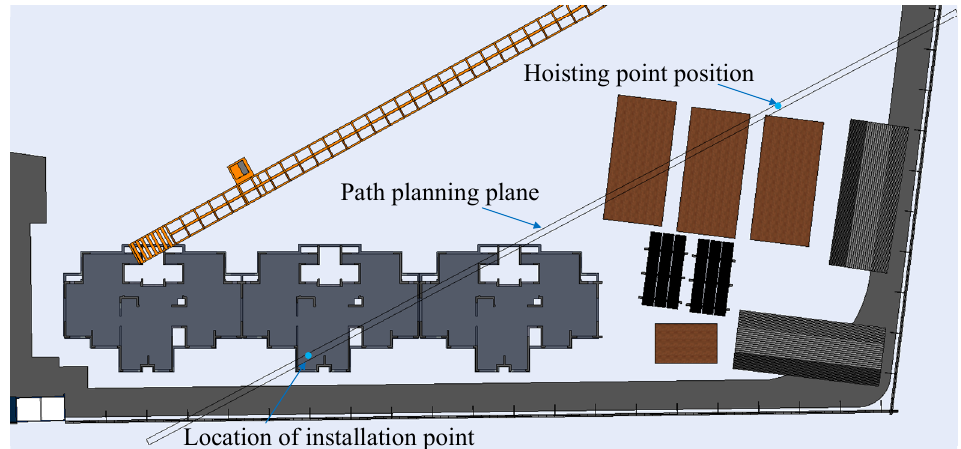
Figure 3. Hoisting location schematic diagram based on DT-BIM model.